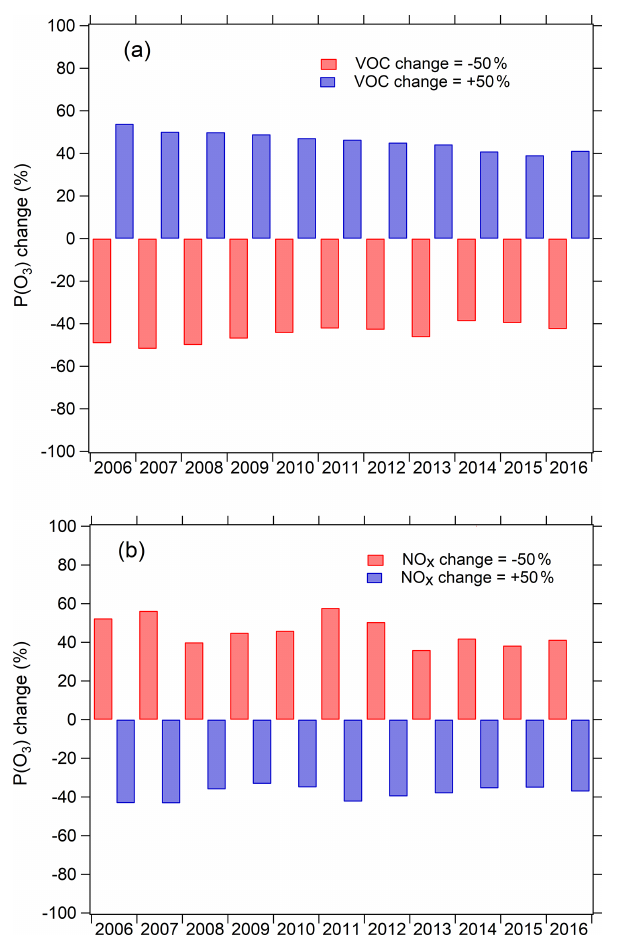
Figure 10. Sensitivity of monthly daytime mean P ( O 3 ) to VOCs and NO x simulated by box model during 2006–2016. VOCs and NO x are increased by 50% or decreased by 50% to test the frac- tional change in monthly daytime mean P ( O 3 ) .